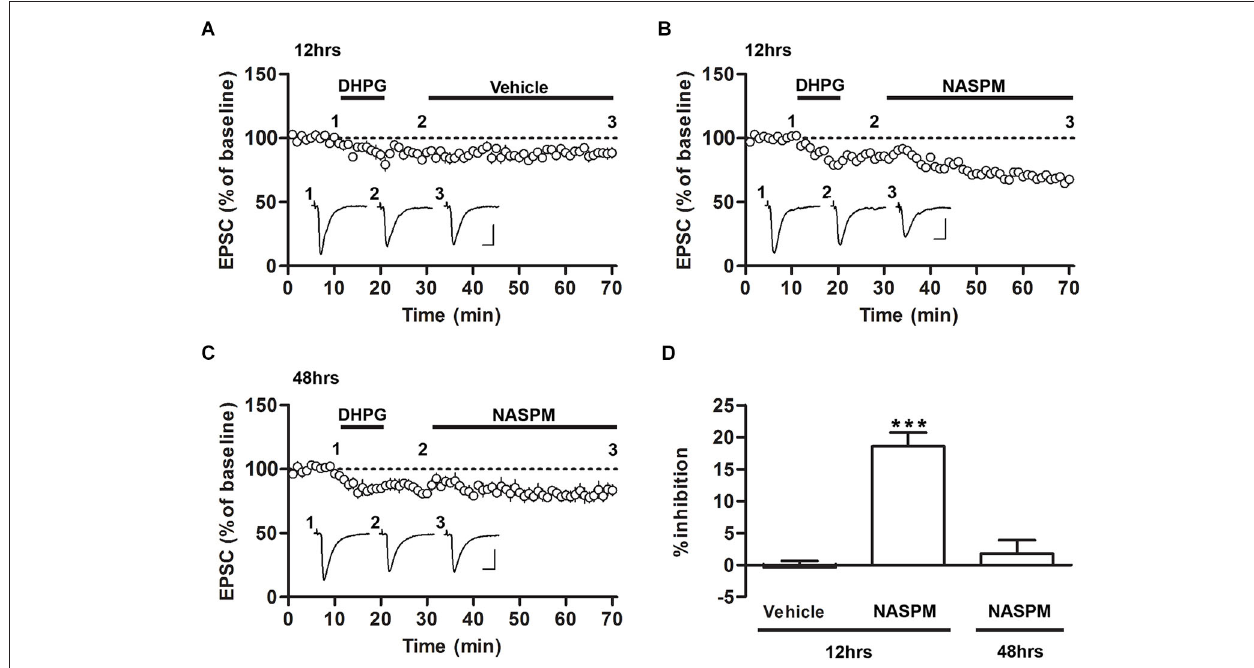
further changes in EPSCs after the onset of DHPG-induced depression. The slices were prepared 48 h after conditioning. All the experiments shown in this figure were performed in the presence of D-AP5 (50 µ M). (D) A summary of the results shown in (A–C) (percent inhibition due to NASPM treatment for the three experiments). *** p < 0.001. Scale bars: 100 pA and 10